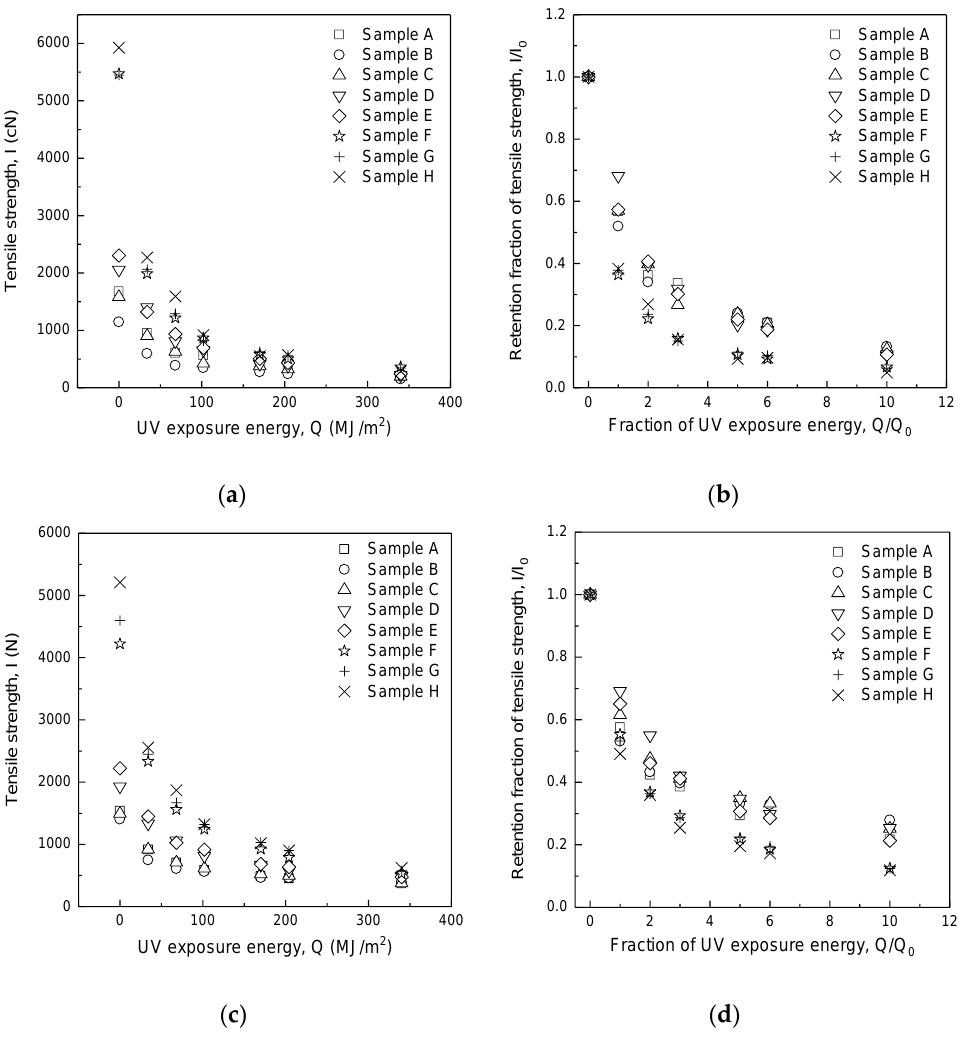
Figure 5. Comparison of yarn tensile strength ( a ) and retention fraction of tensile strength ( b ) and fabric data ( c , d ) for different m-Aramid/p-Aramid blends.